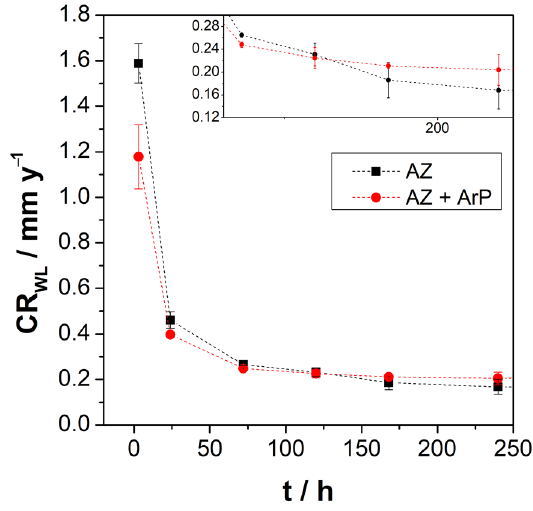
Figure 10. Corrosion rate vs. immersion time determined by weight loss experiments.